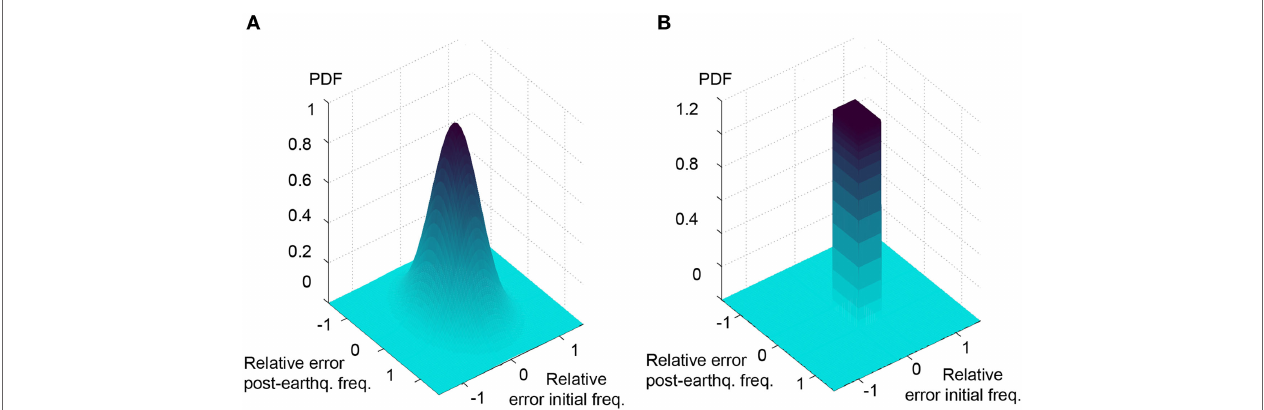
FIGURE 4 | Likelihood functions for traditional Bayesian model updating (TBMU) (left) and modified Bayesian model updating (MBMU) (right) calculated using true model error values (Scenario S 2 in Table 2 ). (A) Zero-mean normal likelihood function for TBMU. (B) Non-zero-mean uniform likelihood function for MBMU.